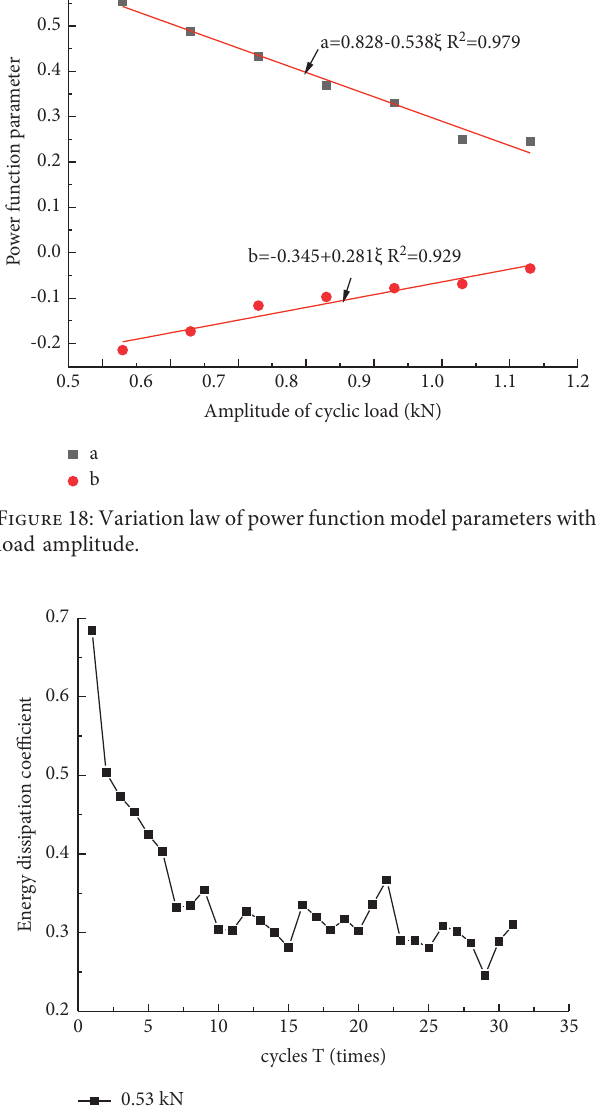
Figure 19: The relation between energy dissipation coefficient of LK4 and number of cycles.